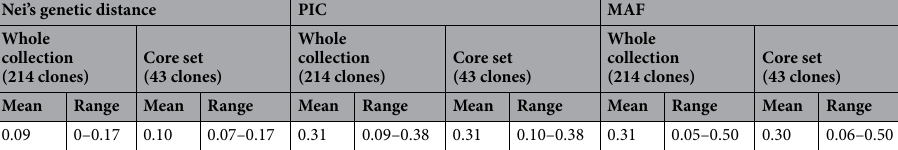
Table 2. Comparison of the genetic diversity of the whole collection (214 clones) versus a core set (43 clones) based on genetic distance, polymorphism information content (PIC) and minor allele frequency